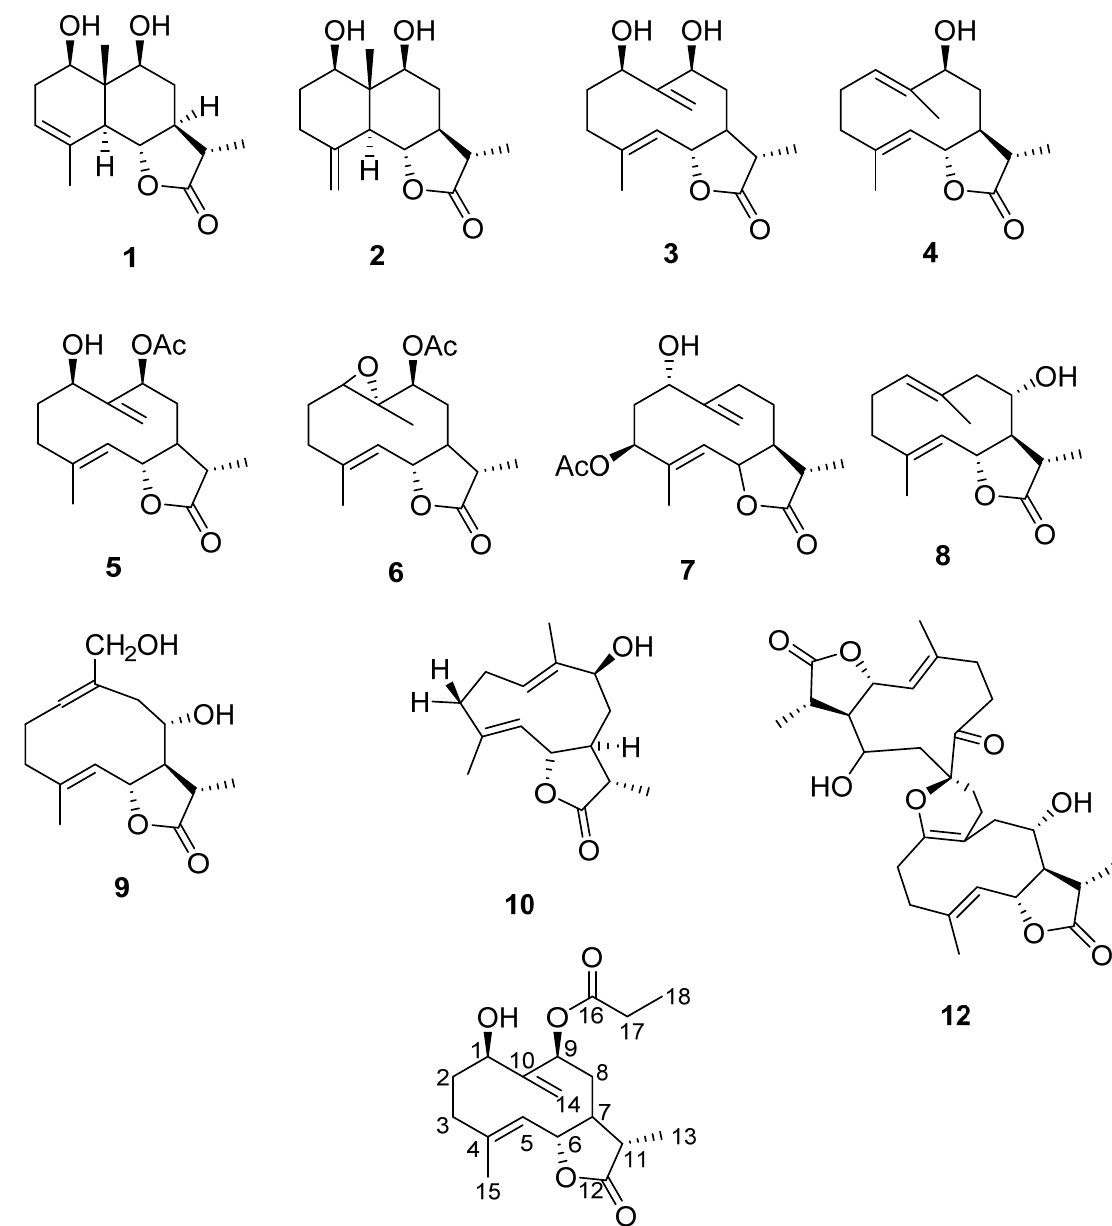
Figure 3. Chemical structures of compounds 1 – 12 from A. nitrosa. Molecules 2022 , 27 , x FOR PEER REVIEW 7 of 14 Compound 11 , obtained as a colorless oil, had a molecular formula of C 18 H 26 O 5 on the basis of UV, ESIMS, TOFMS, LC–MS, and NMR spectroscopic data. The TOFMS showed m / z 322.087 (Figure S13 Supplementary Material); UV (MeOH) λ max (log Ɛ ) 256 (2.07) (Figure S12).The 1 H NMR spectrum data displayed signals of three methyl groups ( δ H 1.58 (d, J = 1.3 Hz, 3H), 1.27 (d, J = 6.9 Hz, 3H), and 1.11 (t, J = 7.6 Hz, 3H)), one exocyclic methylene group ( δ H 4.76, 3.93 each d, J = 10.2 Hz), and a characteristic signal of a double bond ( δ H 5.13 (dd, J = 10.2, 1.6 Hz, 1H)) (Table 1). The 13 C NMR and DEPT NMR spectra indicated 18 carbon resonances, including 3 methyls ( δ C 17.48, 12.55, 8.53), 5 methylenes ( δ C 37.54, 36.81, 30.76, 27.64, 114.37), 6 methines ( δ C 80.05, 78.81, 74.36, 51.05, 41.56, 121.28), and 4 quaternary carbons ( δ C 177.43, 175.06, 153.51, 145.18) (Table 1). The data suggested that compound 11 might be a germacrane-type of sesquiterpene